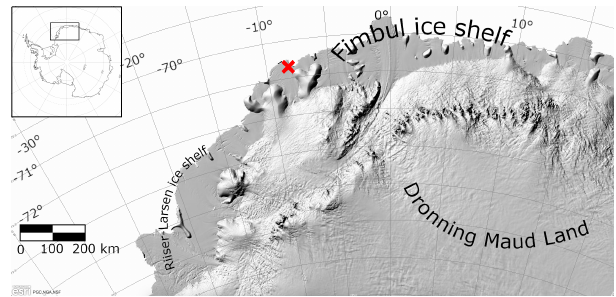
Figure 1. Map of the Antarctic continent. The red cross indicates the location of Neumayer Station. Imagery (©) 2016 DigitalGlobe,